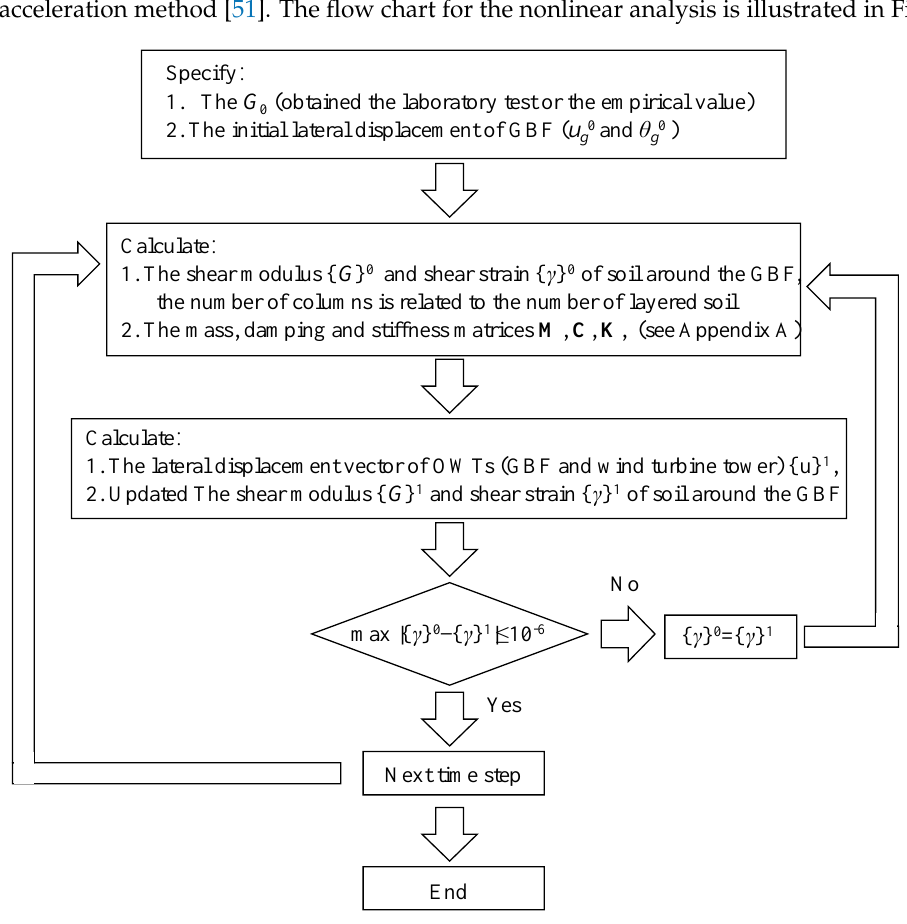
Figure 5. Flow chart for the nonlinear analysis.